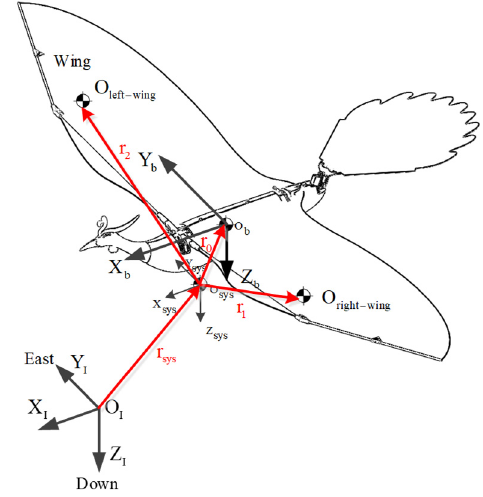
Figure 9. Vector position diagram of aircraft centroid.